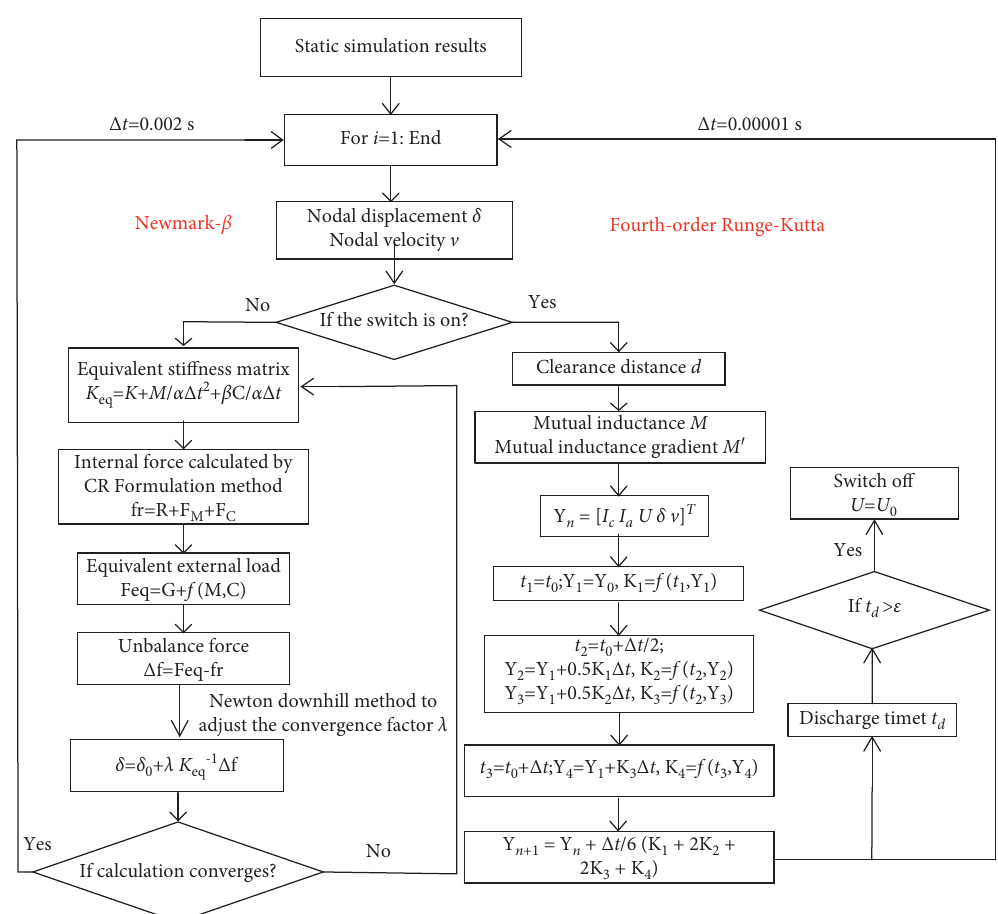
Figure 14: Flowchart of the whole process Figure 15. The vertical displacement-time curve of each measuring point on the conductor is shown in